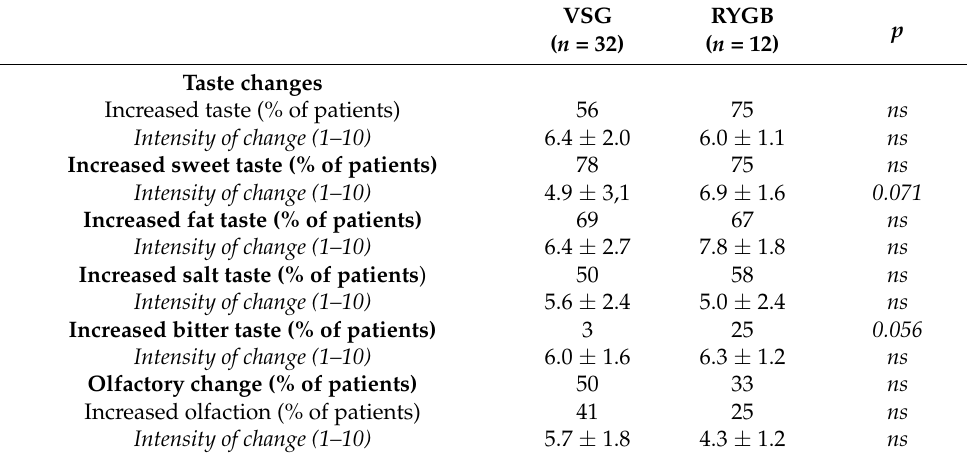
Table 3. Reported gustatory and olfactory changes (TOC questionnaire) 6 months after